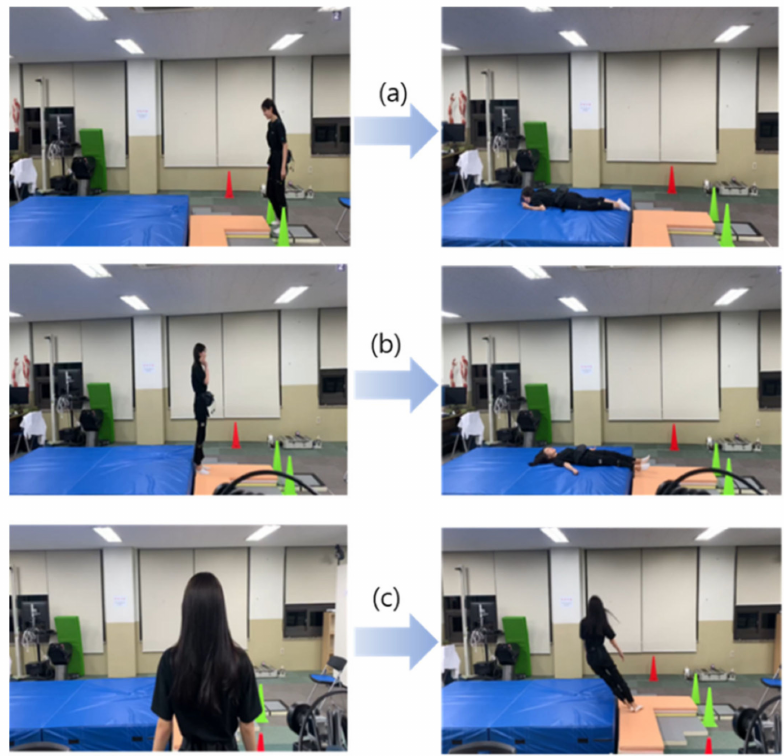
Figure 4. Falls data acquisition experiment; ( a ) forward, ( b ) backward, and ( c ) sideward fall